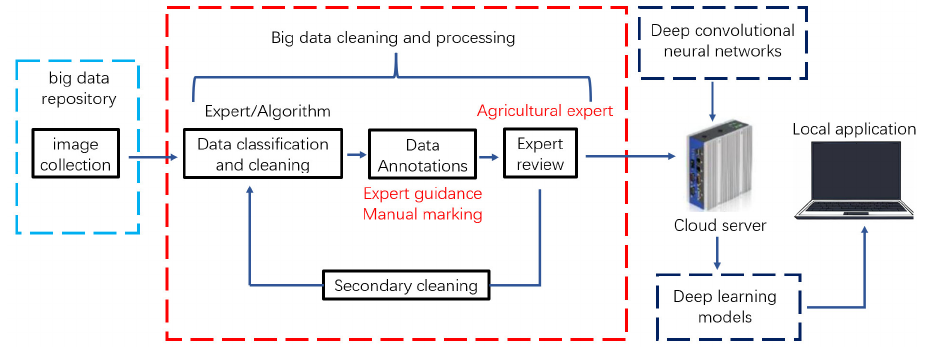
Figure 2. Deep-learning process.